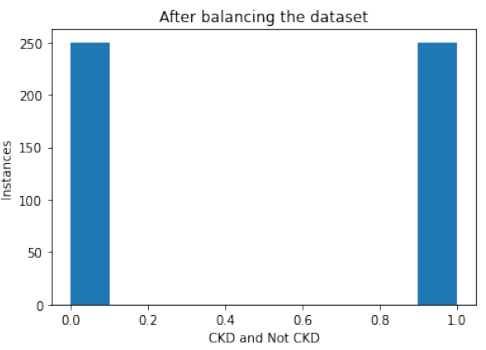
Figure 4. Instances after